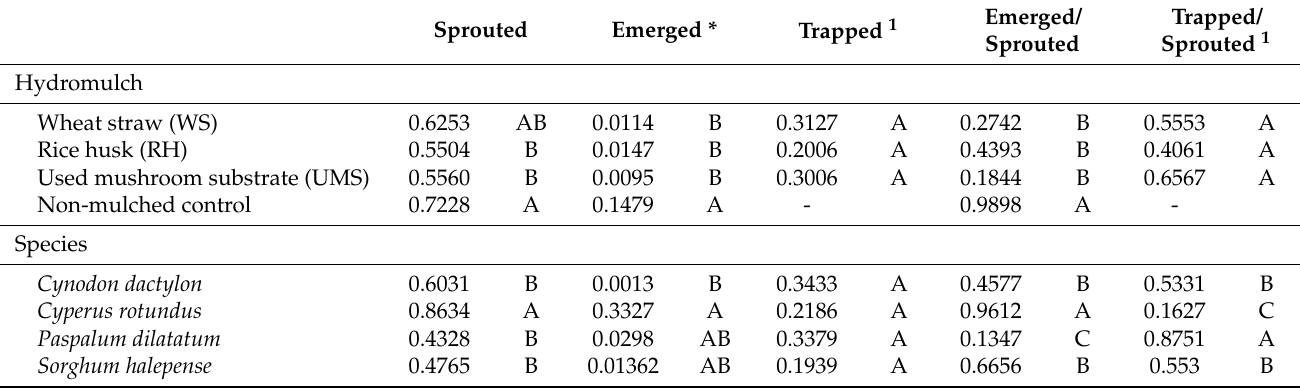
Table 3. Least-squares means for the levels of the two main fixed effects, type of hydromulch and species, corresponding to the analyses of proportions of sprouted rhizomes (SPROUTED), of rhizomes that produced emerged shoots (EMERGED), of rhizomes that produced shoots trapped under the hydromulch (TRAPPED), of sprouted rhizomes whose shoot emerged (EMERGED/SPROUTED), and of sprouted rhizomes whose shoots were all trapped under the hydromulch (TRAPPED/SPROUTED), all of them according to generalized linear mixed models of binomial distribution. In each effect and variable, least-squares means with the same letter are not considered significantly different at p < 0.05 (Tukey–Kramer test).